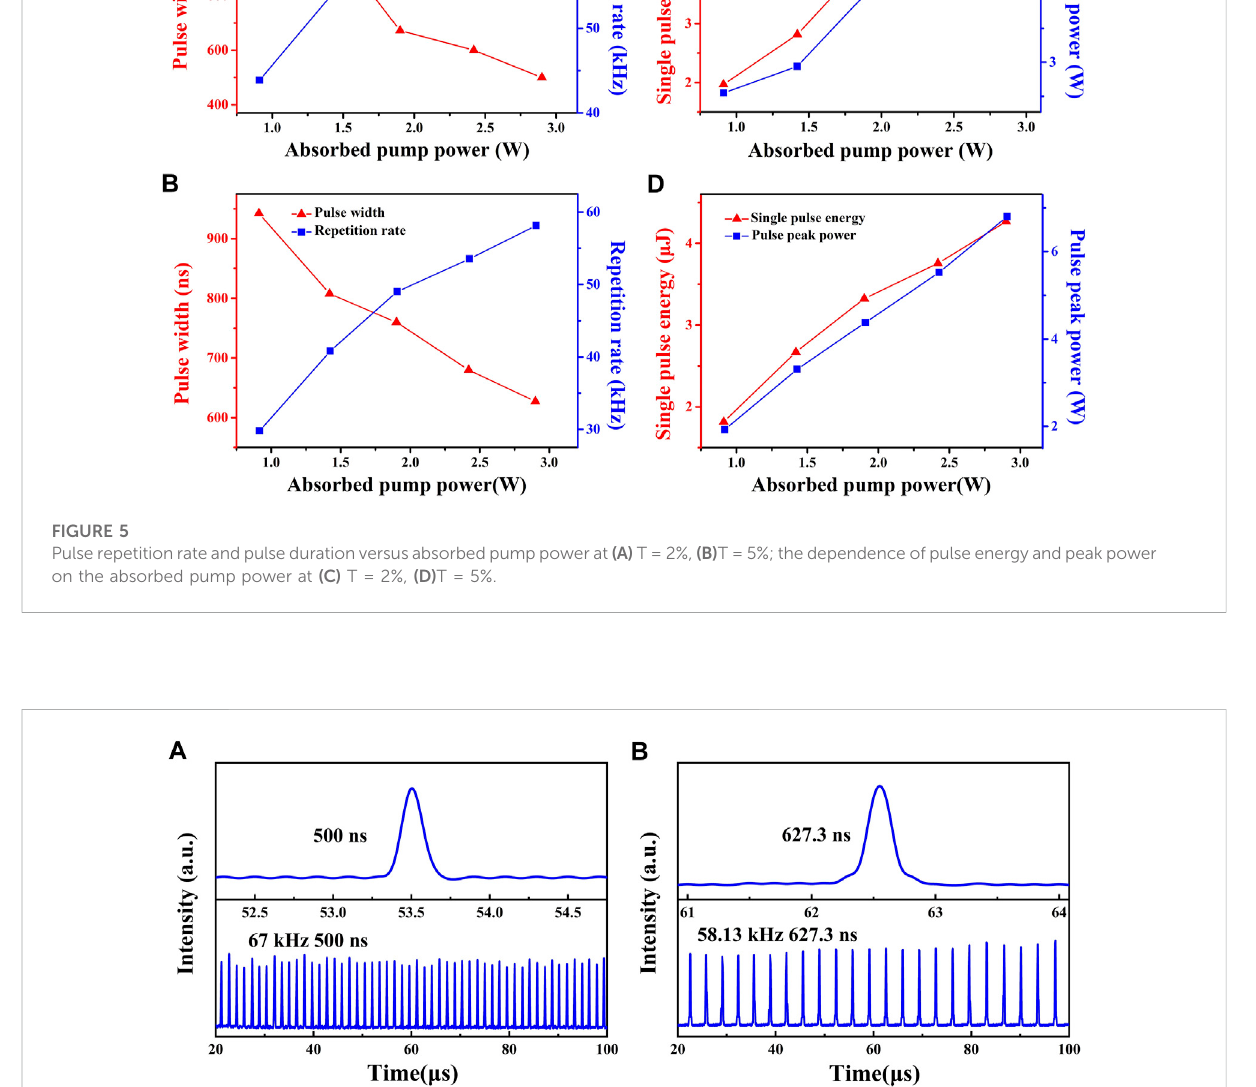
Under the maximum absorbed pump power, the shortest pulse width and maximum pulse repetition rate with the transmittance of 2% are 500 ns and 67 kHz, respectively. A maximum single-pulse energy was reached to 5.39 μ J, corresponding to a maximum peak power of 10.78 W, as